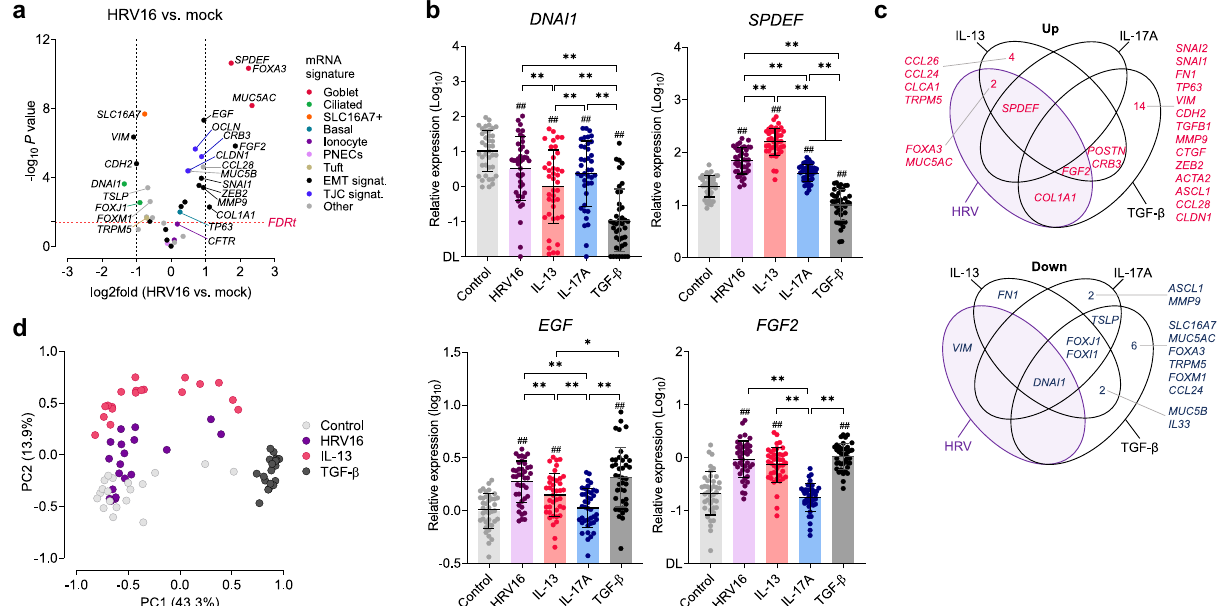
Figure 3. HRV16 infection modulates the expression of genes associated with remodeling of the bronchial epithelium. ( a ) Relative expression changes in structural and EMT-related genes in ALI-grown bronchial epithelium (32 days) infected with HRV16 (48 h). Vertical dashed lines indicate log2fold -1 or 1 (n = 19; 2-sided t-test P < 0.05 at FDRt q = 0.05). ( b ) Relative expression of DNAI1 , SPDEF , EGF , and FGF2 in HRV16-infected mucociliary epithelium compared to uninfected cells cultured in different conditions. Data are shown as means and SD (n = 40). RM 1-way ANOVA (Tukey): * P < 0.05, ** P < 0.01. DL detection limit. ( c ) Venn diagrams showing changes in mRNA expression upon HRV16 infection and cytokine treatment. Only genes significantly (log2fold < − 1 or > 1, P < 0.05) up- ( red ) or downregulated ( navy ) when compared to uninfected control conditions are shown. ( d ) Principal component analysis of genes associated with remodeling in HRV16-infected or cytokine treated epithelium (IL-17A dataset not shown for